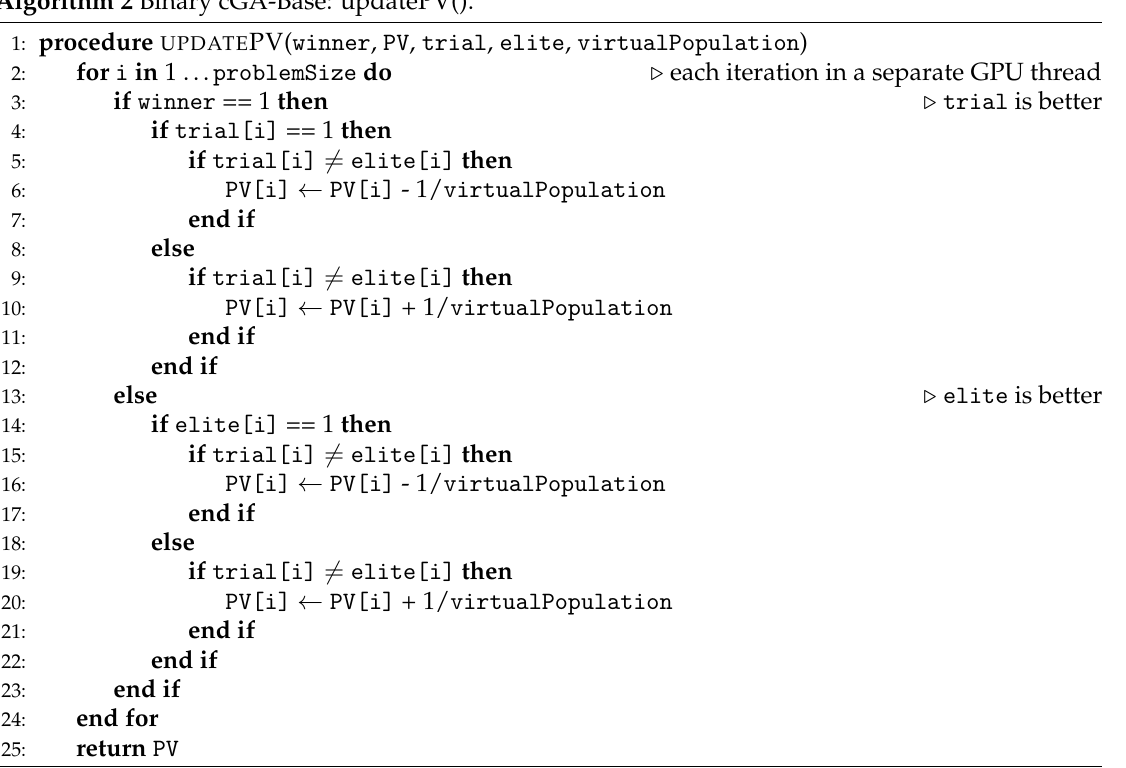
Algorithm 2 Binary cGA-Base: